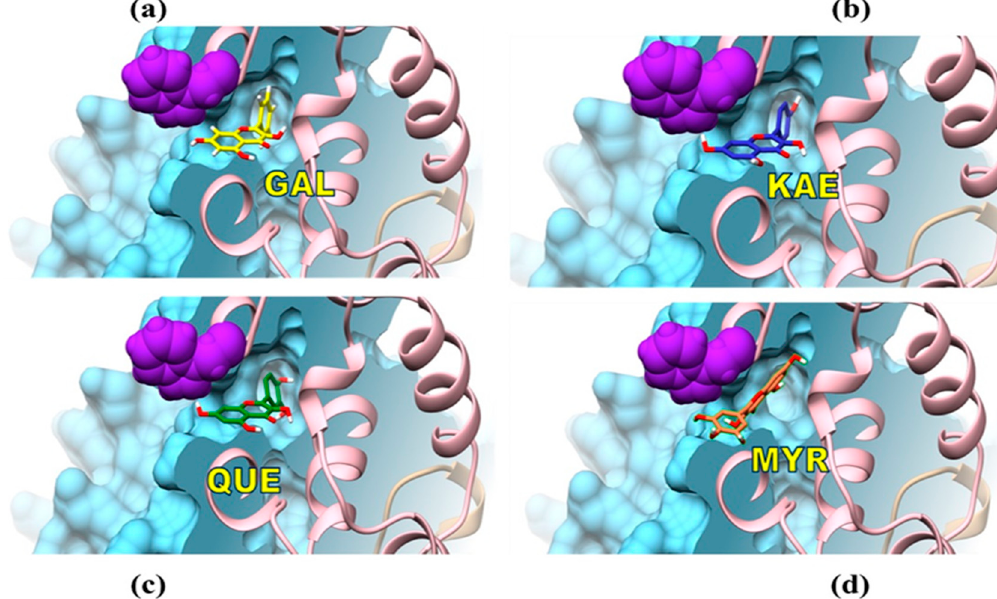
Figure 11. Predicted binding mode between the four flavonols (GAL, KAE, QUE, MYR) and the CpLIP2 lipase achieved by docking experiments. Surface representation of the 3D structure of CpLIP2 lipase showed in bleu cyan color indicating the major potential binding sites of the flavonols adjacent to W294 showed by violet cluster. α -helixes are showed in pink golden. The suggested binding model occupied the access to the catalytic site of CpLIP2 lipase. ( a ) GAL, galangin; ( b ) KAE, kaempferol; ( c ) QUE, quercetin; ( d ) MYR, myricetin with their own binding energy calculated at − 9.1, − 8.6, − 8.6, − 8.1 kcal/mol, respectively.